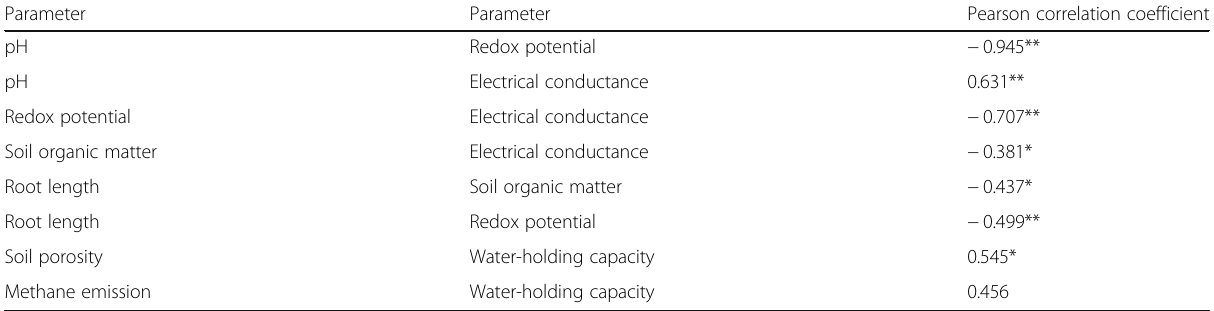
Table 4 Correlation coefficient with some of the parameters of soil and plant during the crop growth period where values marked with* indicate significant difference at a significance level of 5% and with** indicate that at a significance level of